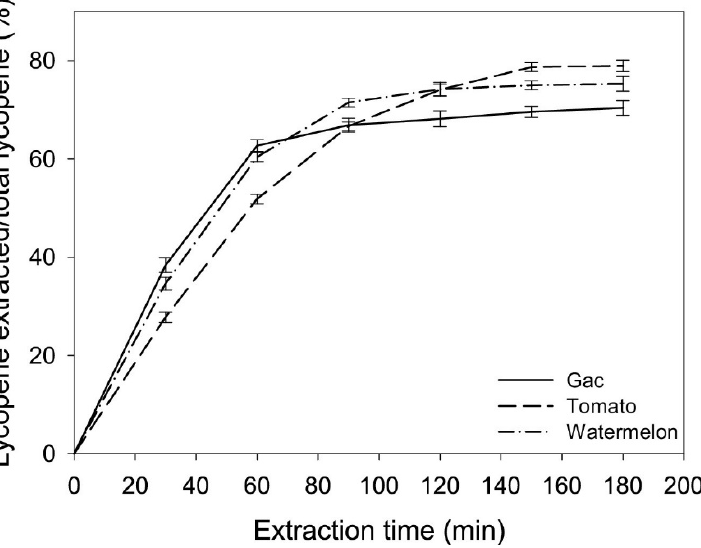
Figure 8. Supercritical CO 2 extraction yield over time for three fruits (gac, tomato and watermelon). Reproduced from [81].